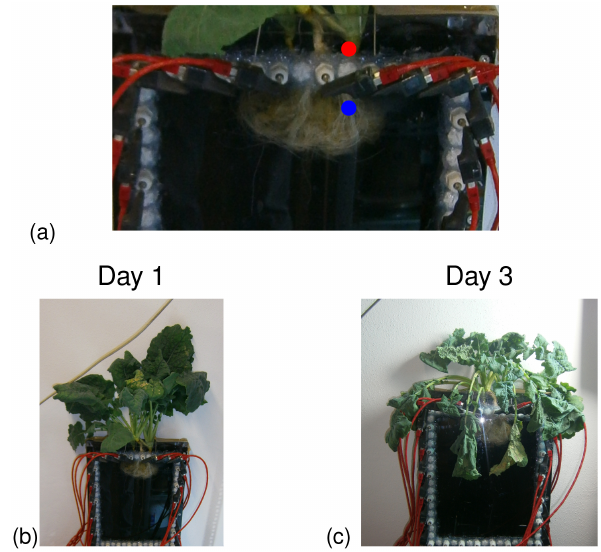
Figure 4. Photographs of the oilseed plants during the experiment: (a) close-up of the root systems in the rhizotron container, (b) day 1 and (c) day 3. The colored dots in (a) indicate the approximate position at which intrinsic signatures, recovered from tomographic inversion results, are investigated; red dot: stem area; blue dot: fine root